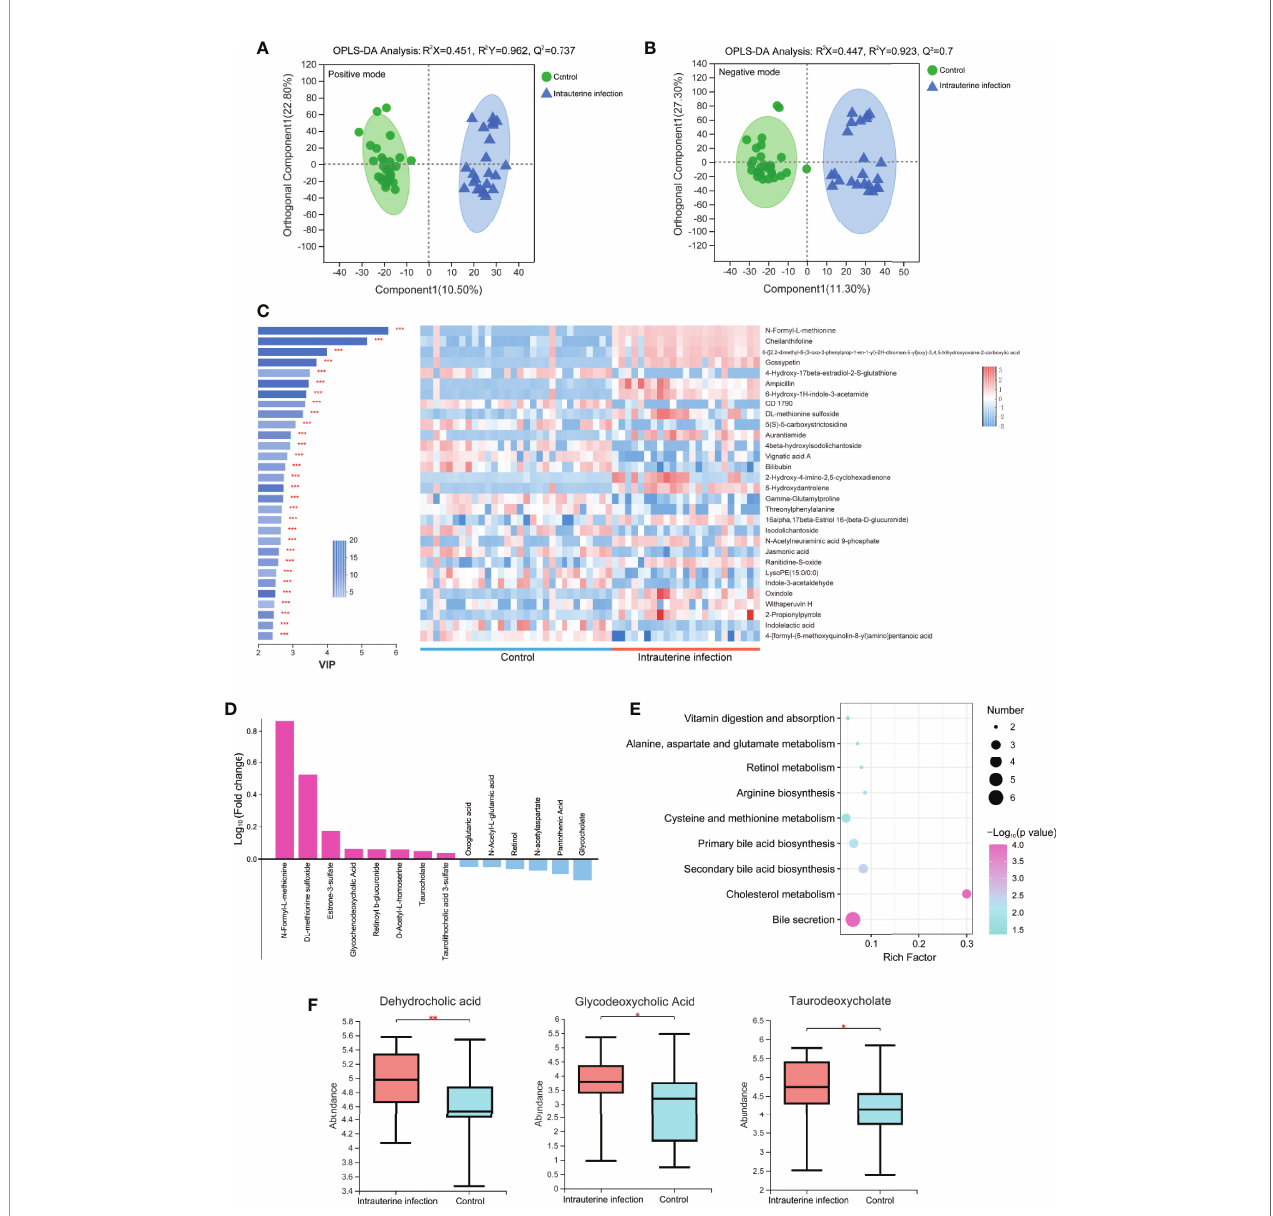
FIGURE 4 | OPLS-DA models of the metabolites between the intrauterine infection group and control group in positive ion mode (A) and negative ion mode (B) . The variable importance in the projection generated in the OPLS-DA analysis between the intrauterine infection group and control group in positive and negative ion modes (C) . (D) Log 10 fold-change of the metabolites involved in vitamin digestion and absorption, retinol metabolism, primary bile acid biosynthesis, secondary bile acid biosynthesis, cholesterol metabolism, bile secretion, cysteine and methionine metabolism, arginine biosynthesis, and the alanine, aspartate, and glutamate metabolism pathways. (E) Enriched pathways between the intrauterine infection group and control group in positive and negative ion modes. (F) Abundance of dehydrocholic acid, glycodeoxycholic acid, and taurodeoxycholate between the intrauterine infection group and control group. “ * ” meansP values smaller than 0.05; “ ** ” means P values smaller than 0.01; “ *** ” means P values smaller than